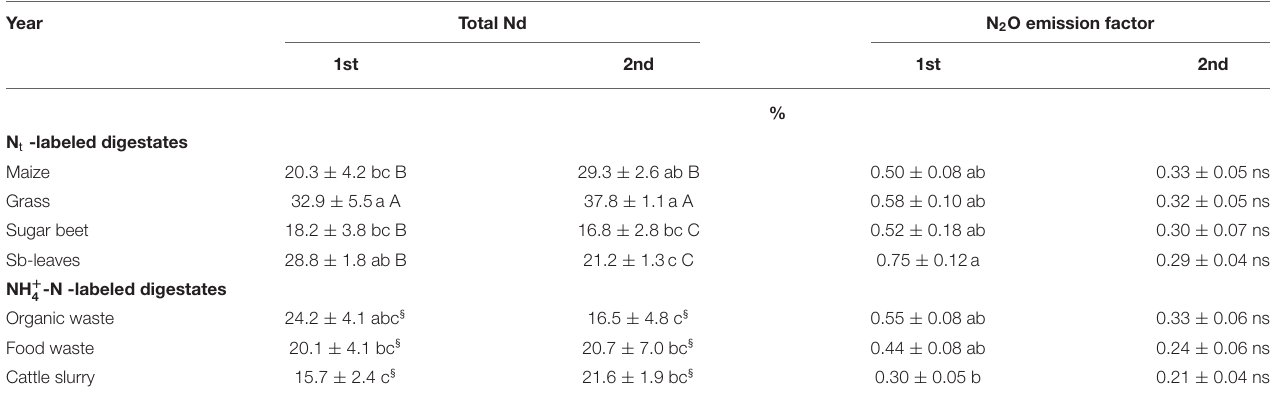
TABLE 5 | Share of digestate derived N 2 O-N on total N 2 O emissions (Total Nd) and N 2 O-N emission factors after 55 (1st) and 58 days (2nd year).